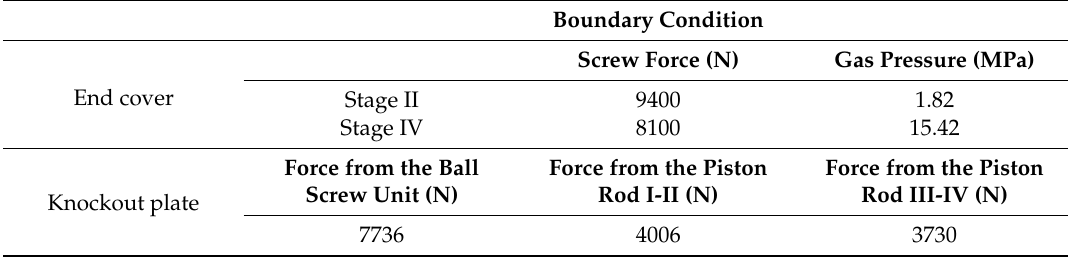
Figure 7. Boundary conditions of the stress and sti ff ness analysis of the knockout plate. Table 4. Boundary conditions for the stress